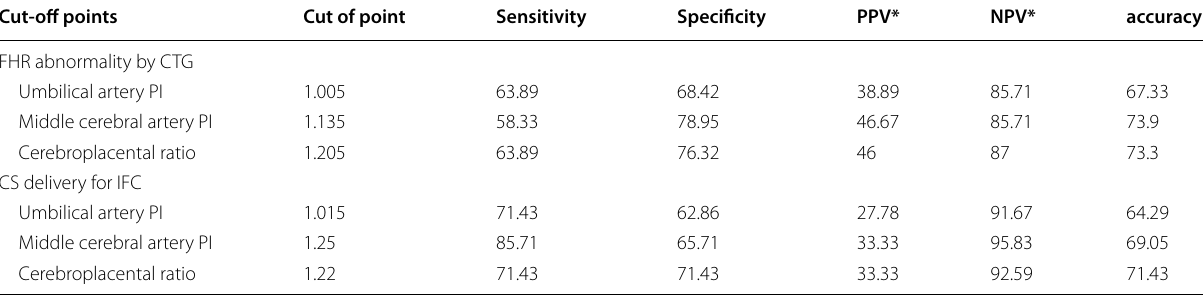
Table 4 Sensitivity, specificity, PPV, NPV, and diagnostic accuracy of different sonographic parameters for prediction of adverse intrapartum